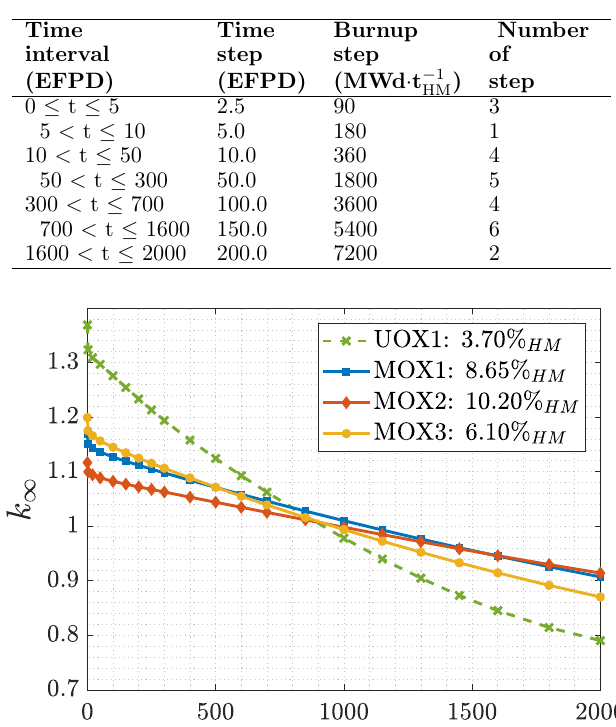
Table 5. Diffusion database time sampling.